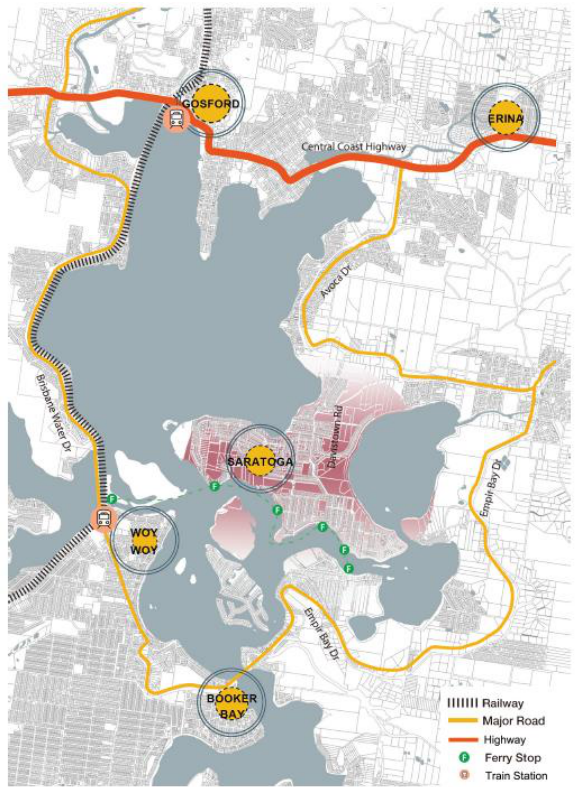
Figure 1: Brisbane Water five major communities and potential additional infrastructure envisaged in one of the scenarios for Saratoga (Map by Studio